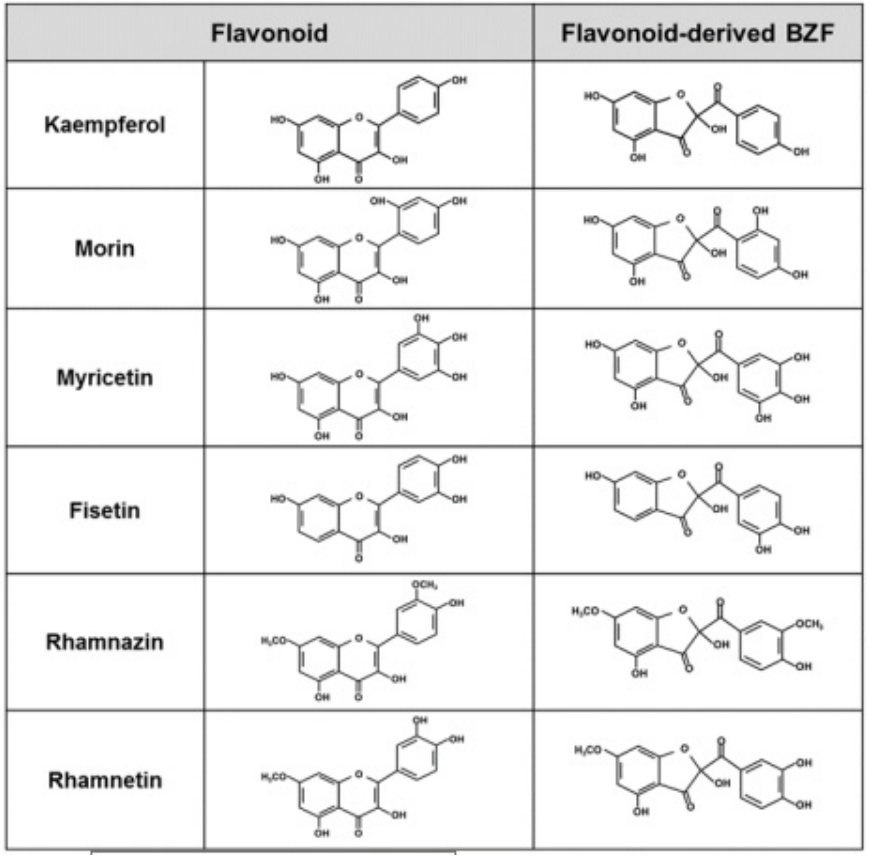
Figure 3. Chemical structures of flavonoids and their corresponding 2-(benzoyl)-2-hydroxy-3(2H)- benzofuranone derivatives.